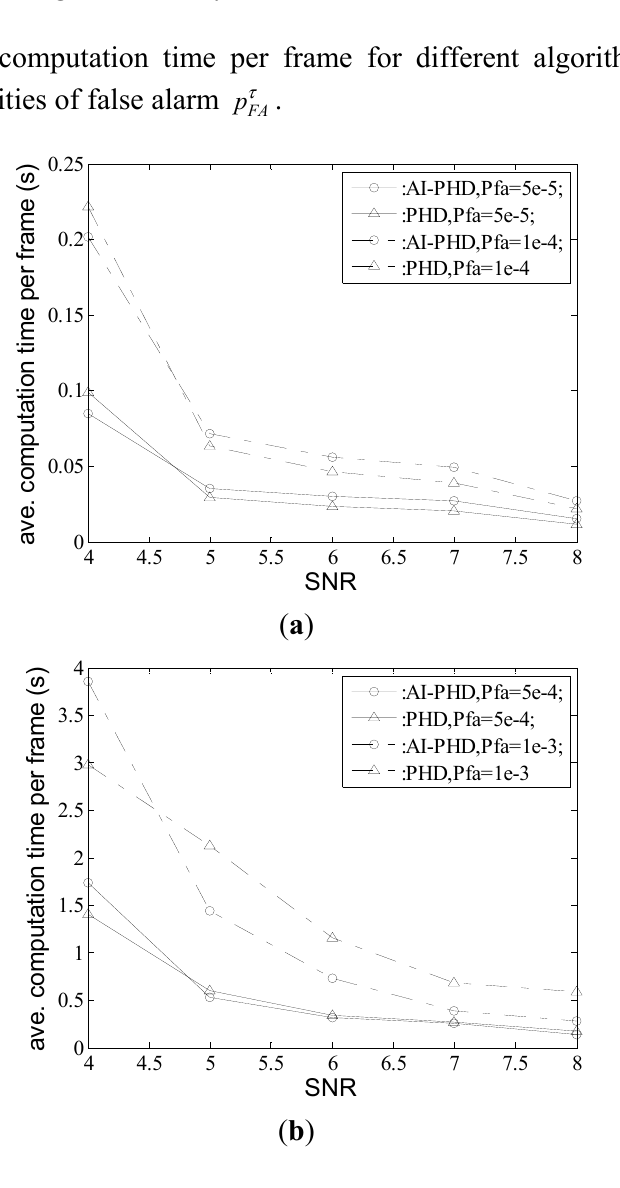
Figure 4. Average computation time per frame for different algorithms with different SNRs d and probabilities of false alarm